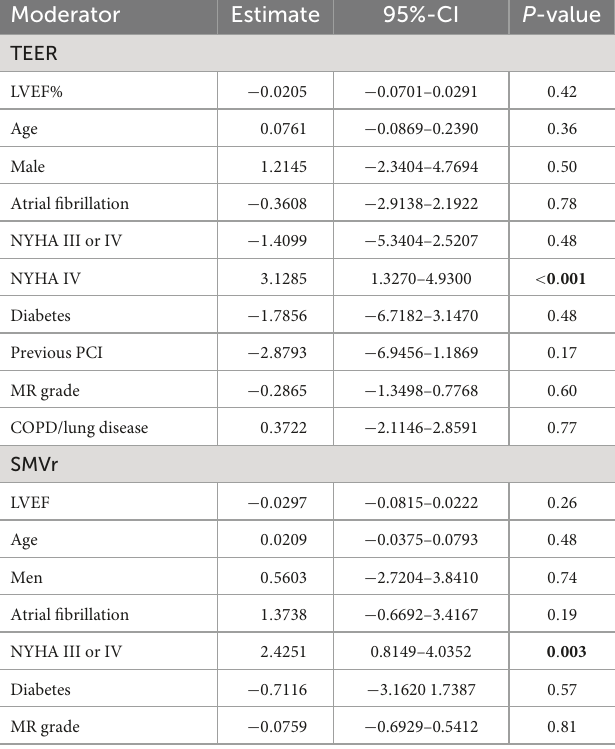
TABLE 2 Meta-regression of potential moderators in the TEER and the SMVr cohort for 30-day mortality.